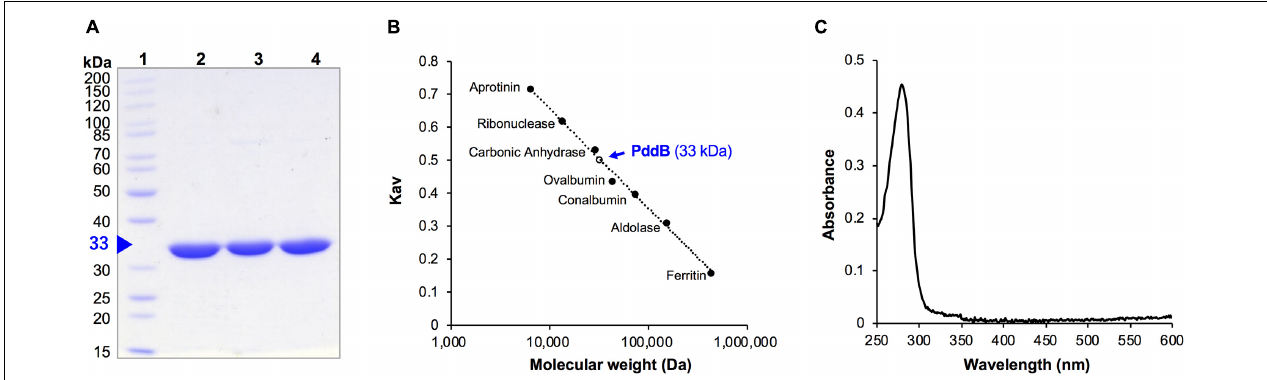
FIGURE 2 | Purification and physicochemical characterization of PddB. (A) Purity of wild-type PddB and its mutants evaluated in this study. The purified proteins were analyzed on SDS-PAGE and stained with Coomassie Brilliant Blue R-250. Lane 1, molecular weight marker; lane 2, wild-type PddB; lane 3, C101A mutant;